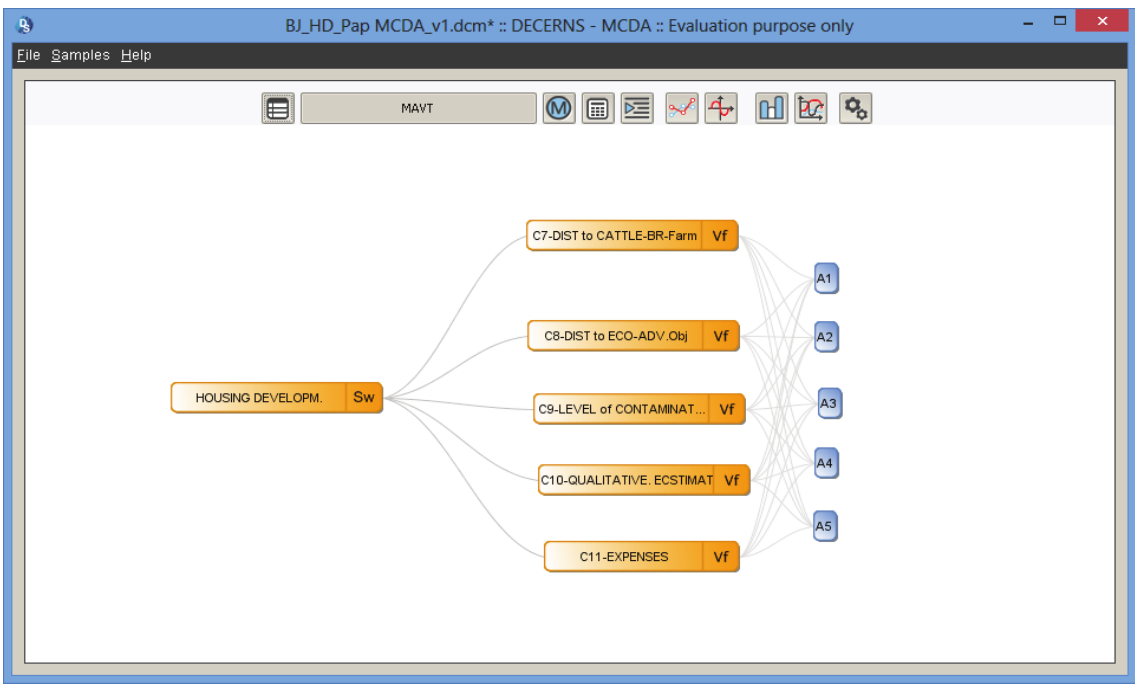
Fig.4. DecernsMCDA : Value Tree.